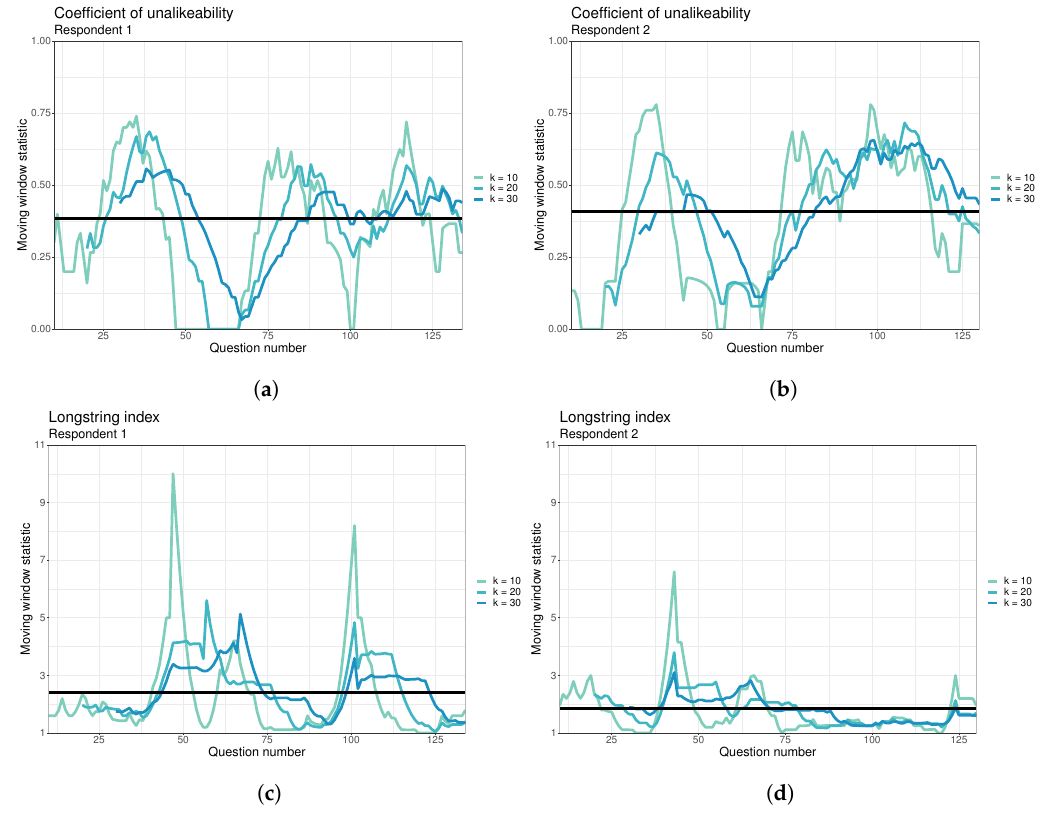
Figure 1. Example of application of the two moving-window metrics defined in Section 3.2, considering two different respondents to the face-to-face survey studied and k ∈ { 10,20,30 } . Specifically, the values of ˜ u mov ( x ) for respondents 1 and 2 are shown in ( a , b ), respectively, whereas the corresponding values of ˜ (cid:96) mov ( x ) are shown in ( c , d ). The black horizontal line represents the average value of the moving-window metric for the respondent. Table 2. Summary statistics of the two moving-window metrics defined in Section 3.2 (considering k = 20) for the face-to-face and telephone surveys under